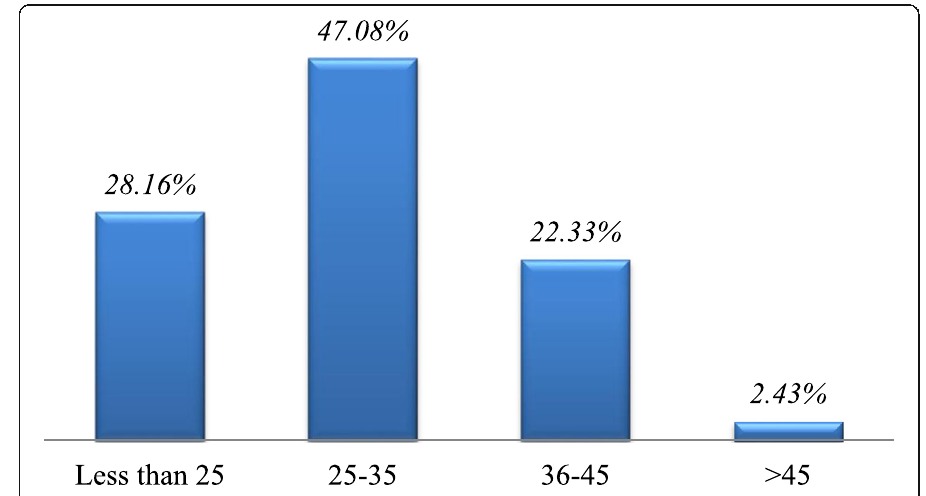
Fig. 5 Age distribution of entrepreneurs. Source: author ’ s computation based on firm survey